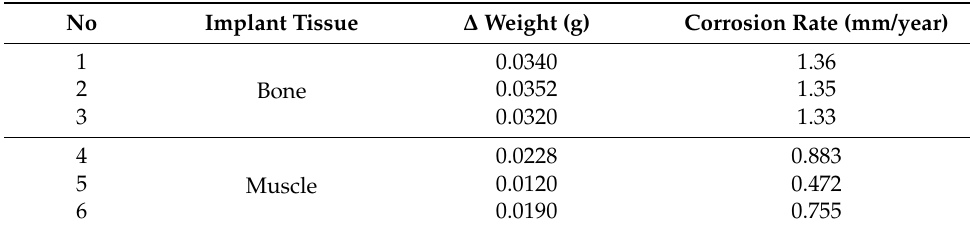
Table 4. Statistical analysis, corrosion rate (CR) SBF vs. in vivo .